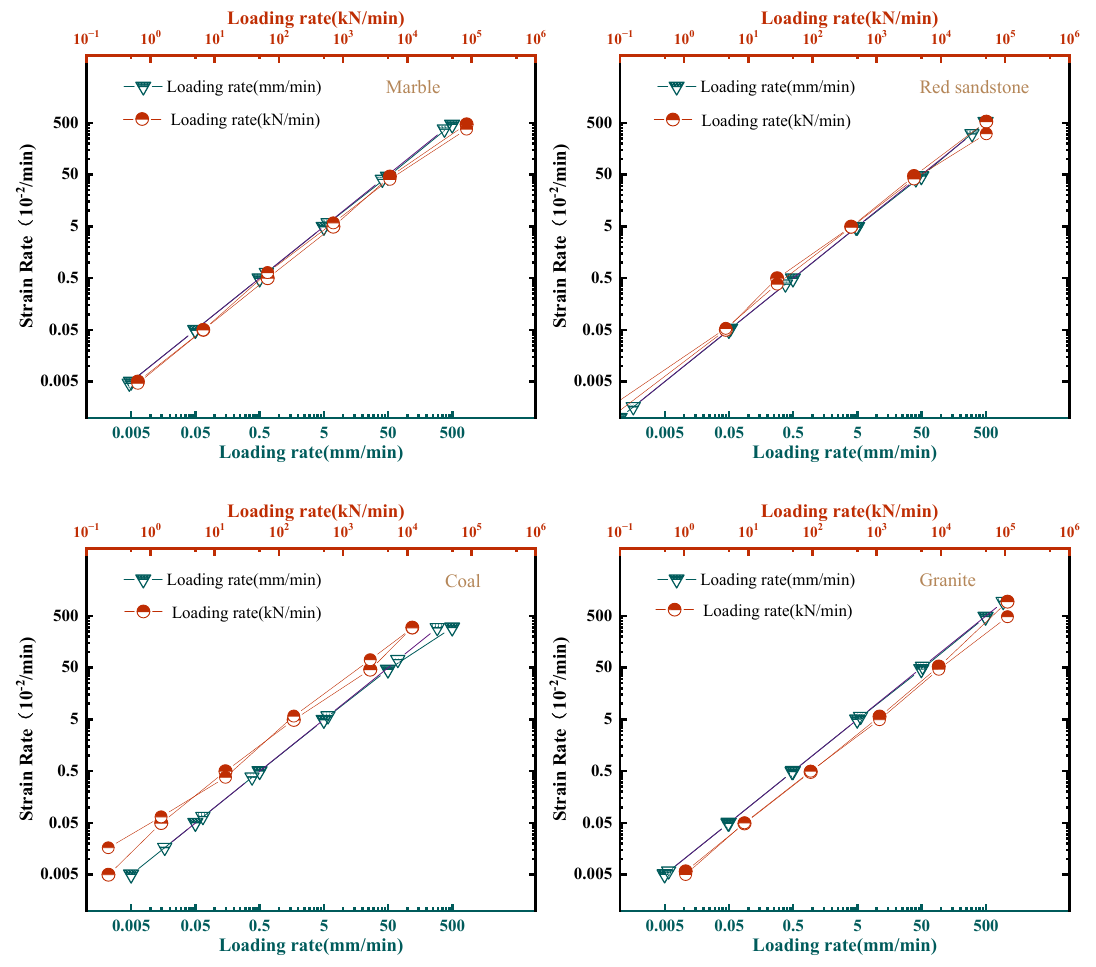
Figure 12. Relationship between experimental rate and strain rate of different rocks. In this study, the SDR was affected greatly by the strain rate of rocks. The uniaxial compressive strength σ c increased about 1.2 times, while Dt increase much more than σ c , as shown in Figure 13. As can be seen from the figures, the Dt starts to increase rapidly when it is larger than 0.7 mm/min. Therefore, for the displacement loading rate, 0.1–0.7 mm/min is recommended. The classification and evaluation criteria of B and SDR in non-energy rockburst in- ignored. It is also found that the evaluation results of a kind of rock under different